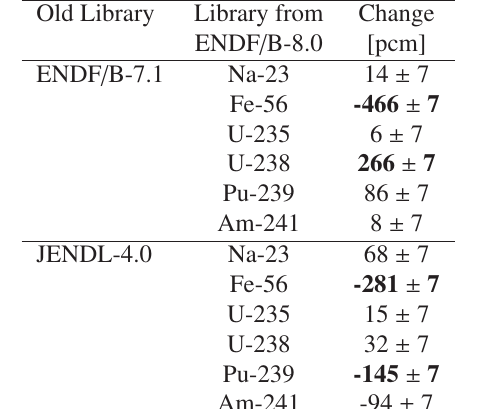
Figure 2. Radial Layout of Oxide Core [1]